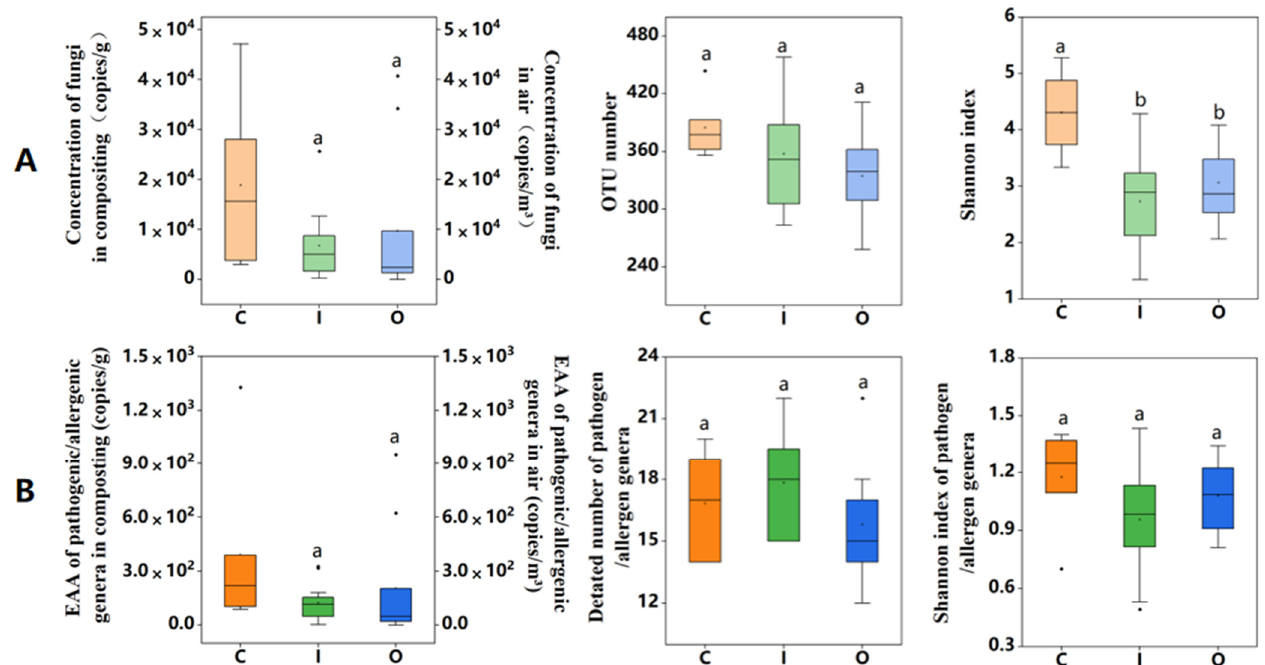
Figure 1. Abundance and diversity of fungal genera and pathogenic/allergenic genera in composting piles (C), inside air (I), and outside air (O) of composting workshop. ( A ) Concentration, OTU number, and Shannon indices of total fungal genera; ( B ) the estimation of absolute abundance (EAA), detected number, and Shannon indices of pathogenic/allergenic genera. (There is a significant difference between “a” and “b” above the box diagram; p < 0.05).